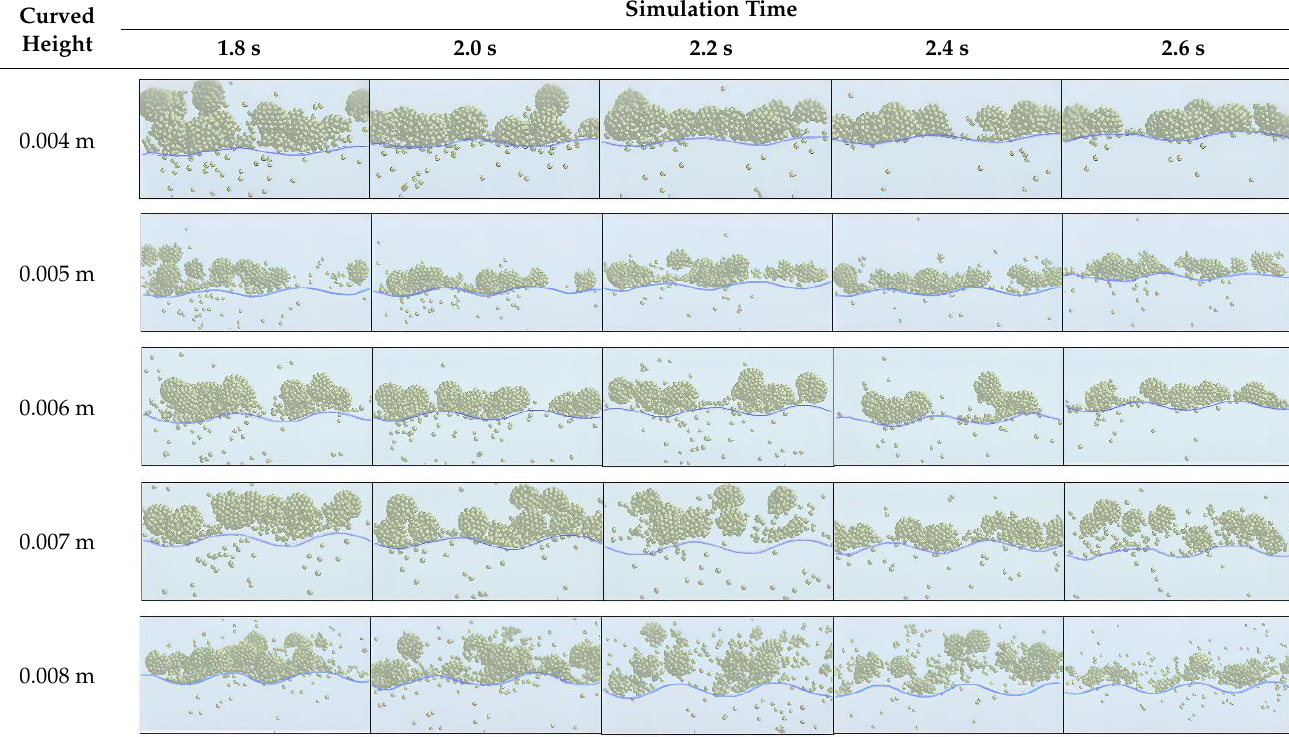
Table 6. The motion attitude of agglomerates during the separation of different curved heights.